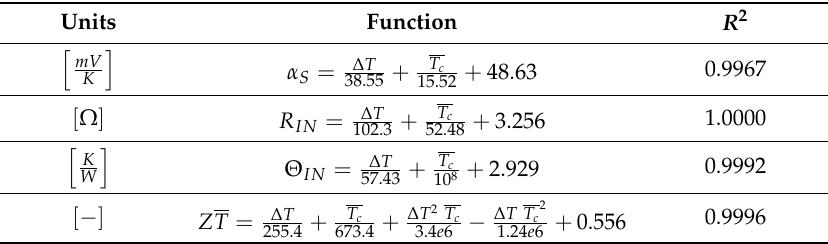
Table 4. Interpolating Functions of the TEM